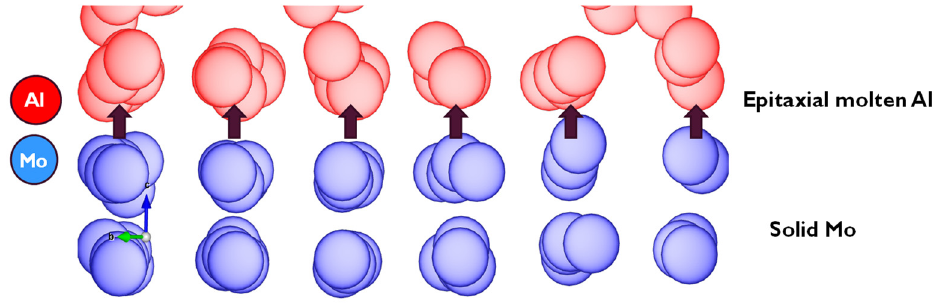
Figure 7. A model depicting the anti-wetting properties of solid metallic Mo in contact with molten Al at 1200 K.